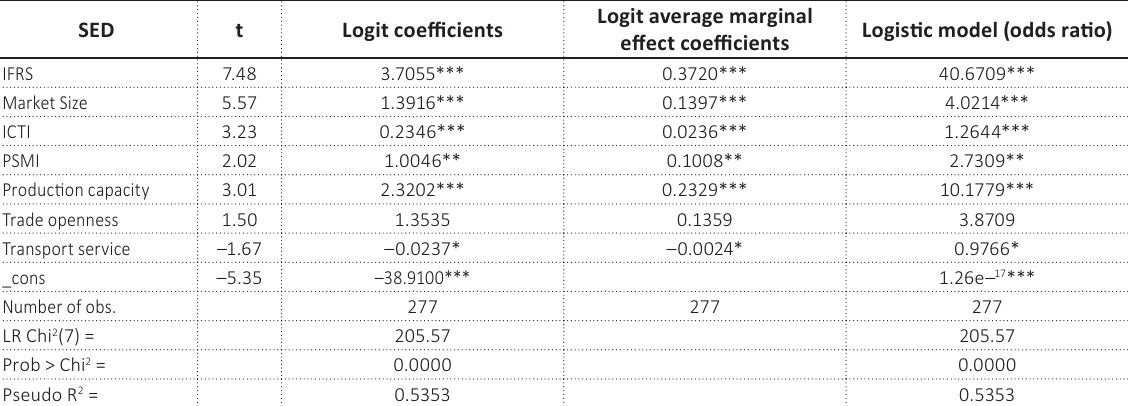
Table 6. Regression